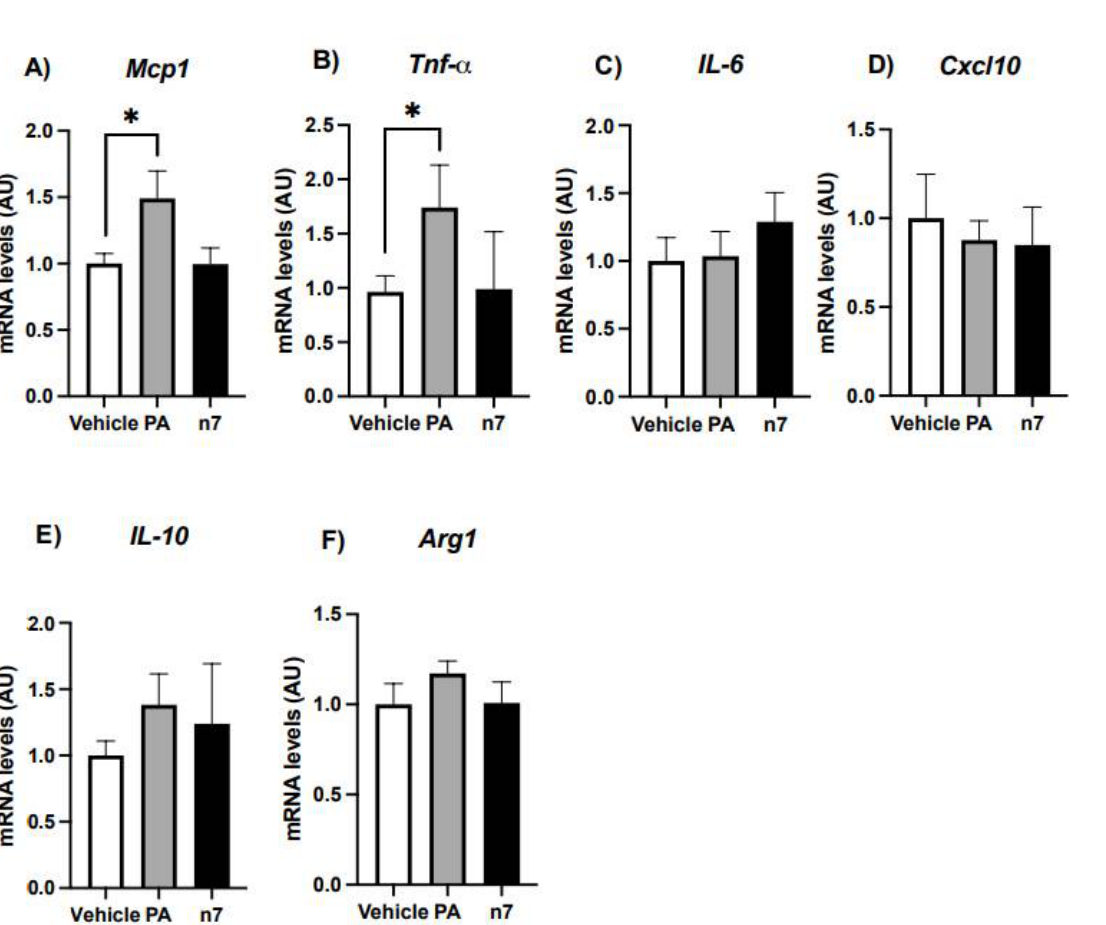
Figure 5. Effects of palmitoleic acid on mRNA levels of cytokines expressed by 3T3-L1 adipocytes.